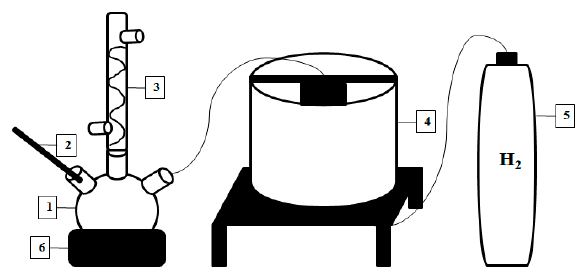
Figure 1. Hydrodeoxygenation (HDO) process scheme. Note: (1) sample bottom flask; (2) thermometer; (3) condenser; (4) reactor; (5) hydrogen gas tank; (6) heater.